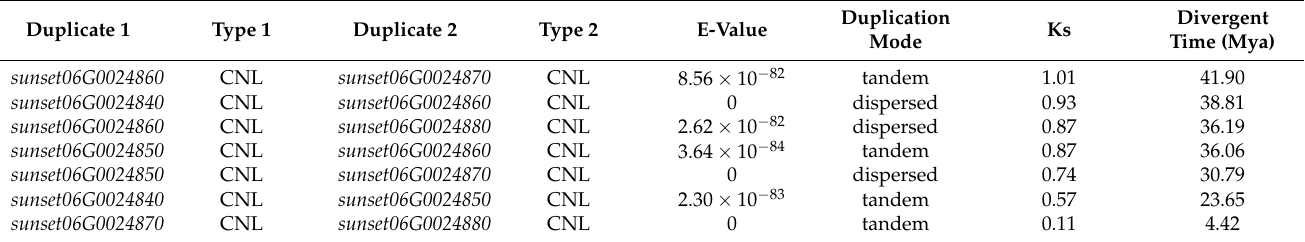
Table 2. Duplication modes and divergent times of a five-CNL-cluster in papaya.